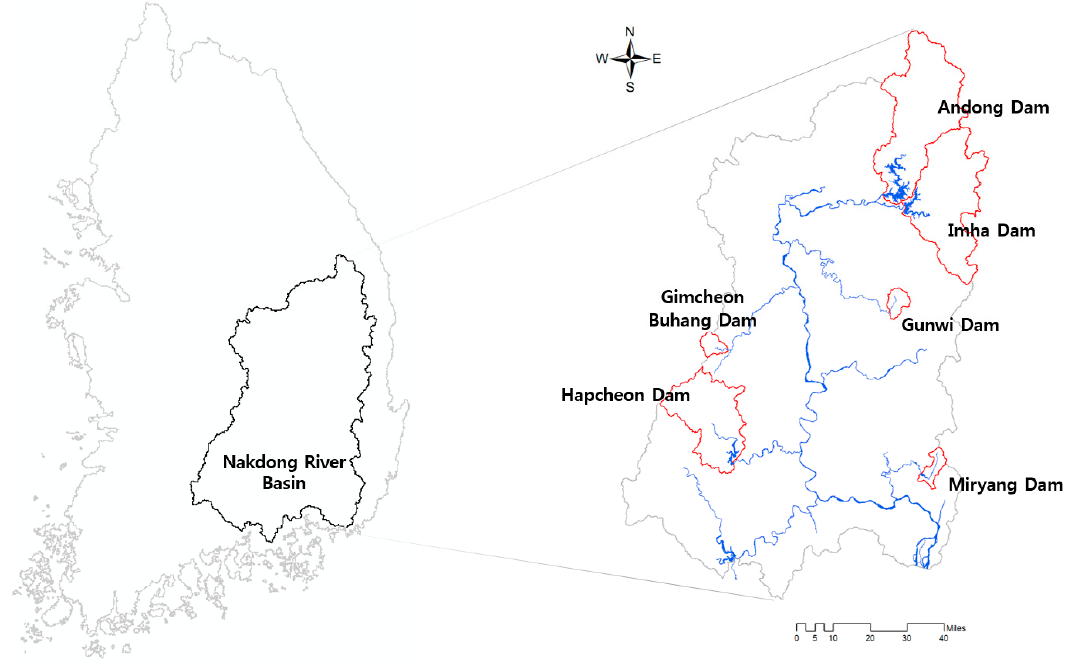
Figure 2. Location of multipurpose dams in the Nakdong River Basin. Table 3. Storage (Unit: 10 6 m 3 ) and ratio (Unit: %) of six multipurpose dams [21].